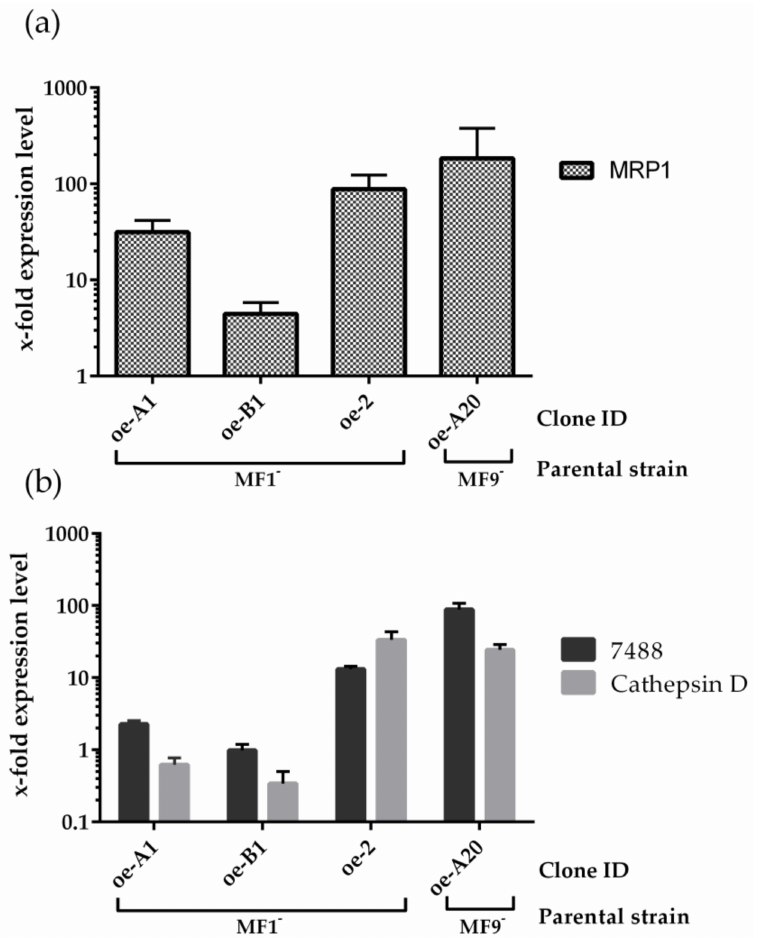
Figure 4. Characterization of the MRP1-overexpressing MT − cells. ( a ) MRP1 qPCR performed on the transformed clones. ( b ) 7488 and Cathepsin D qPCR performed on the 4 transformed clones. means ± SD ( n =